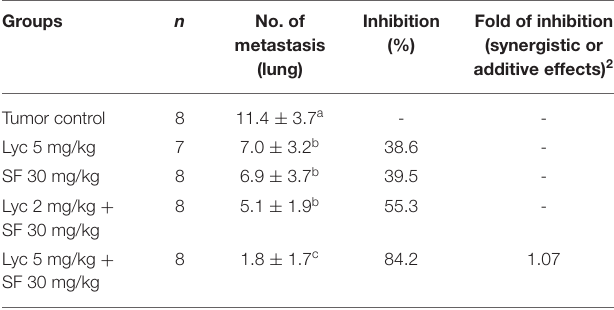
TABLE 1 | Inhibitory effects of lycopene (Lyc) alone, sorafenib (SF) alone, or their combination on the lung metastasis in the C57BL/6 mice xenografted LLC cells 1 .